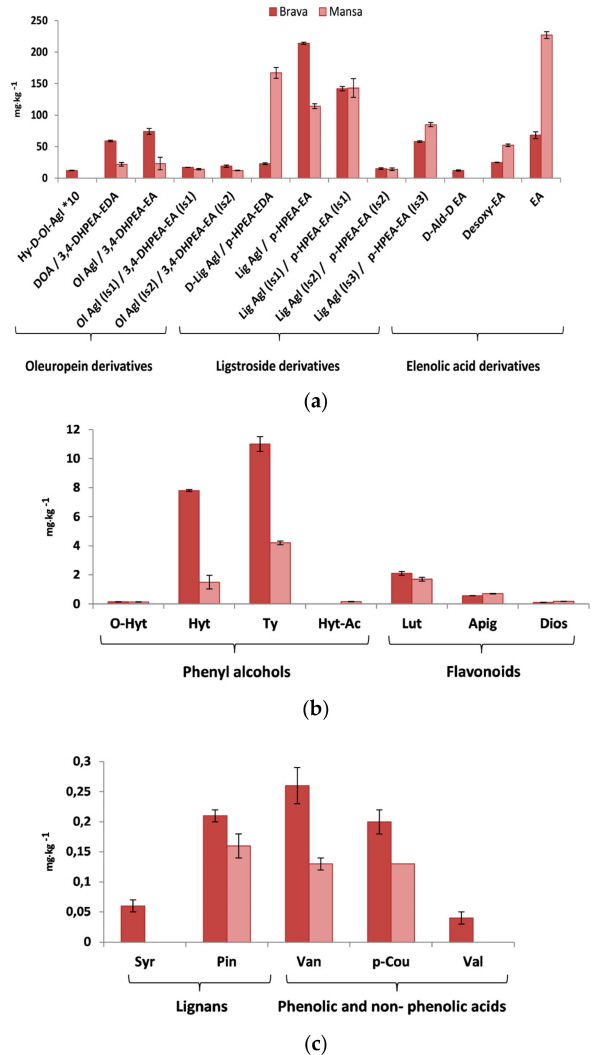
Figure 1. Results correspond to mean ± standard deviation ( n = 3) of phenolic compounds (mg · kg − 1 ) extracted from the evaluated EVOOs by using LC-ESI-IT-MS ( a ) secoiridoids including oleuropein derivatives, ligstroside derivatives and elenolic acid derivatives; ( b ) phenyl alcohols and flavonoids and ( c ) lignans and phenolic and non-phenolic acids. Acronyms: ( a ) Hy- D -Ol-Agl, Hydroxy decarboxymethyl oleuropein aglycone; 10-Hy-Ol-Agl, 10-Hydroxy oleuropein aglycone; DOA/3,4-DHPEA-EDA, Dialdehydic form of decarboxymethyl oleuropein aglycone/Dialdehydic form of decarboxymethyl elenolic acid linked to hydroxytyrosol; Ol Agl/3,4 DHPEA-EA, Oleuropein aglycone (main peak); Ol Agl (Is1)/3,4 DHPEA-EA (Is1), Oleuropein aglycone (Isomer 1); Ol Agl (Is2)/3,4 DHPEA-EA (Is2), Oleuropein aglycone (Isomer 2); D -Lig Agl/ p -HPEA-EDA, Dialdehydic form of decarboxymehtyl ligstroside aglycone/Dialdehydic form of decarboxymethyl elenolic acid linked to tyrosol/Oleocanthal; Lig Agl/ p -HPEA-EA, Ligstroside aglycone; Lig Agl (Is1)/ p -HPEA-EA (Is1), Ligstroside aglycone (Isomer 1); Lig Agl (Is2)/ p -HPEA-EA (Is2), Ligstroside aglycone (Isomer 2); Lig Agl (Is3)/ p -HPEA-EA (Is3), Ligstroside aglycone (Isomer 3); D -Ald- D EA, Decarboxymethylated form of elenolic acid/Dialdehydic form of decarboxymethyl of elenolic acid; Desoxy-EA, Desoxy elenolic acid; EA, Elenolic acid. ( b ) O -Hyt, Oxidized hydroxytyrosol; Hyt, Hydroxytyrosol/3,4-dihydroxyphenylethanol; Ty, Tyrosol/( p -hydroxyphenyl)etanol; Hyt-Ac, Hydroxytyrosol acetate; Lut, Luteolin; Apig, Apigenin; Dios, Diosmetin. ( c ) Syr, Syringaresinol; Pin, Pinoresinol; AcetPin, Acetoxypinoresinol;Van, Vanillic acid; p -Cou, p -Coumaric acid; Val,